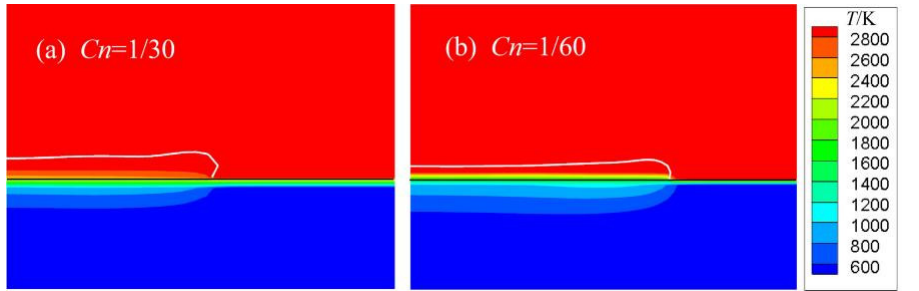
Figure 3. Temperature distribution for ( a ) Cn = 1/30 and ( b ) Cn = 1/60 at 0.6 μs. The white contour denotes drop profile and the temperature is measured in K. The substrate surface is denoted in black.